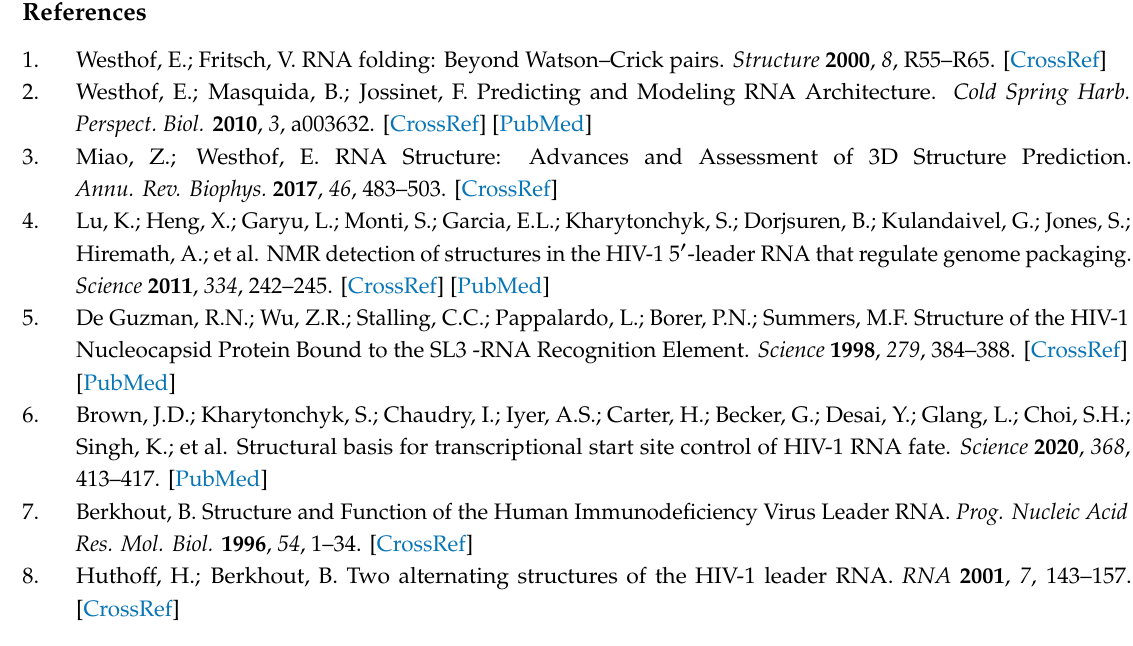
Figure S1: Circle plots of Input and Ouput nt-nt pairings identified for Dimer-prone and Monomer HIVNL4-3. Figure S2: Circle plots comparing 3D output of Monomer with the top 3 clusters of Monomer UnpairedPolyA (cluster 1, 2, 3). Figure S3. Comparison of Input restraints of centroid WT to Dimer or Monomer. Table S1. Number of objects in the top 3 ensembles of objects having the lowest 2% of free energy, Video S1: SimRNA Output 3D Model of Dimer-prone 5 (cid:48) -UTR. Video S2: SimRNA Output 3D Model of Monomer 5 (cid:48) -UTR. Video S1: SimRNA Output 3D Model of Mono PolyA